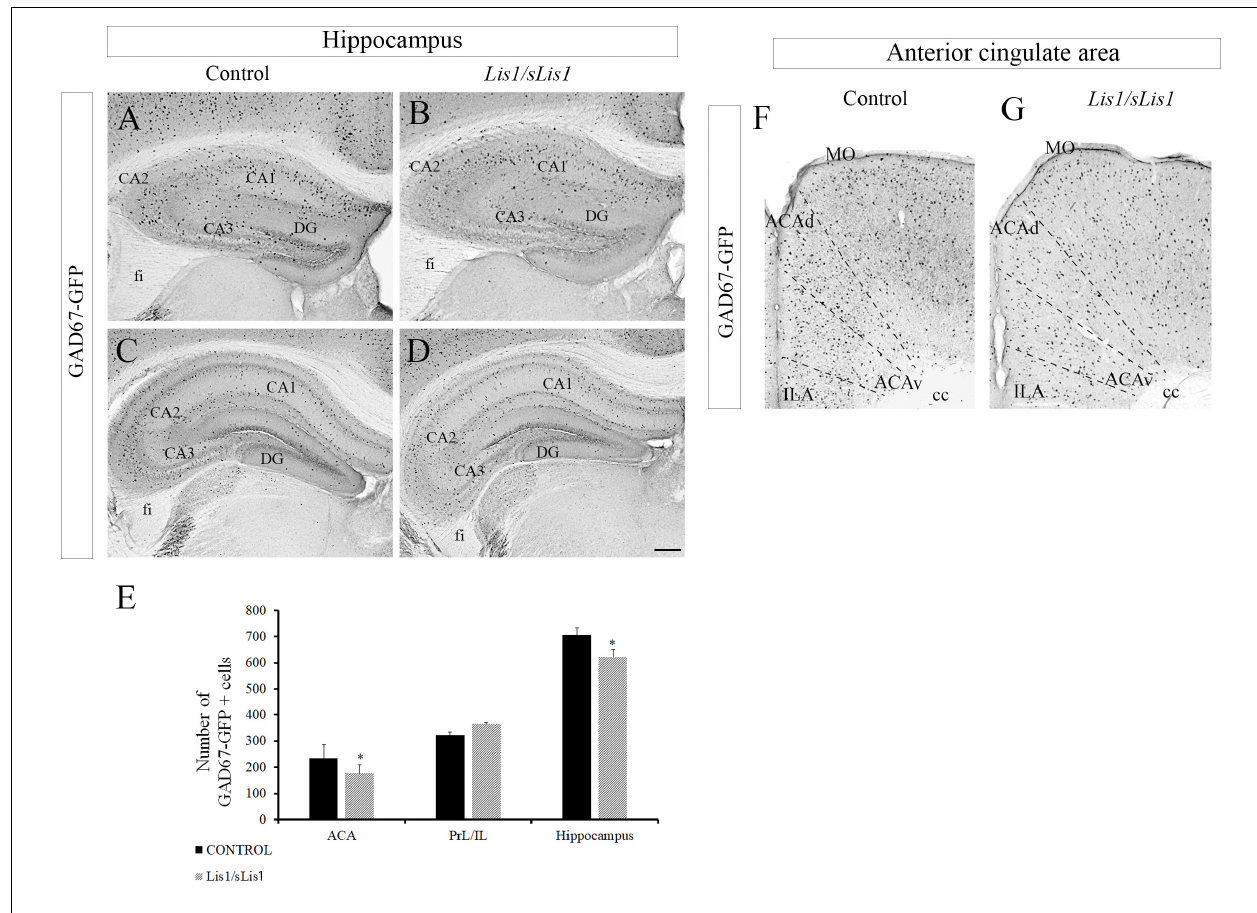
FIGURE 1 | Study of GABAergic interneurons in the hippocampus and anterior cingulate area in Gad67-Gfp × Lis1/sLis1 and Lis1/sLis1 adult mice. Photomicrographs of coronal sections taken through the hippocampal area (A–D) and ACA (F,G) , processed using immunoperoxidase staining for GAD67- anti-green fluorescent protein (GAD67-GFP) chicken polyclonal antibody. (A–D) There were fewer GFP-positive cells in the hippocampus of Lis1/sLis1 mice compared with adult controls. (E) Histogram indicating the average number of GFP+ cells ± SE in the ACA, PrL/ILA and hippocampus. (F,G) The number of GFP-positive cells in the anterior cingulate area of Lis1/sLis1 mice was decreased compared to adult controls. For all panels scale bar is 200 µ m.